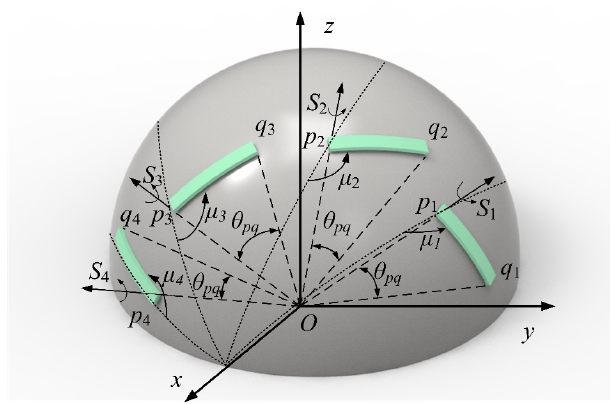
Figure 1. The position and direction of the rigid